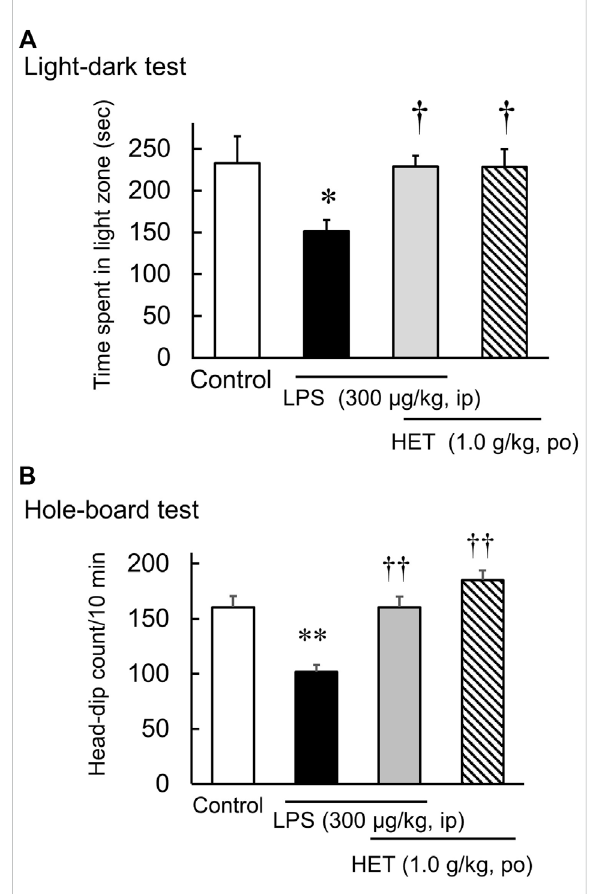
FIGURE 3 Results of the hole-board test and light-dark test conducted after liposaccharide (LPS)-treatment. Preventive effect of hochuekkito (HET) on the number of head-dips of hole-board test (A) andthetime spent inthelightzoneoflight-darktest (B) in control and LPS-treated mice, and mice before LPS-treatment. Data are shown as mean ± SEM; n = 7 – 8 per group. *: p < 0.05 (vs. control), **: p < 0.01 (vs. control), † : p < 0.05 (vs. LPS), †† : p < 0.01 (vs.